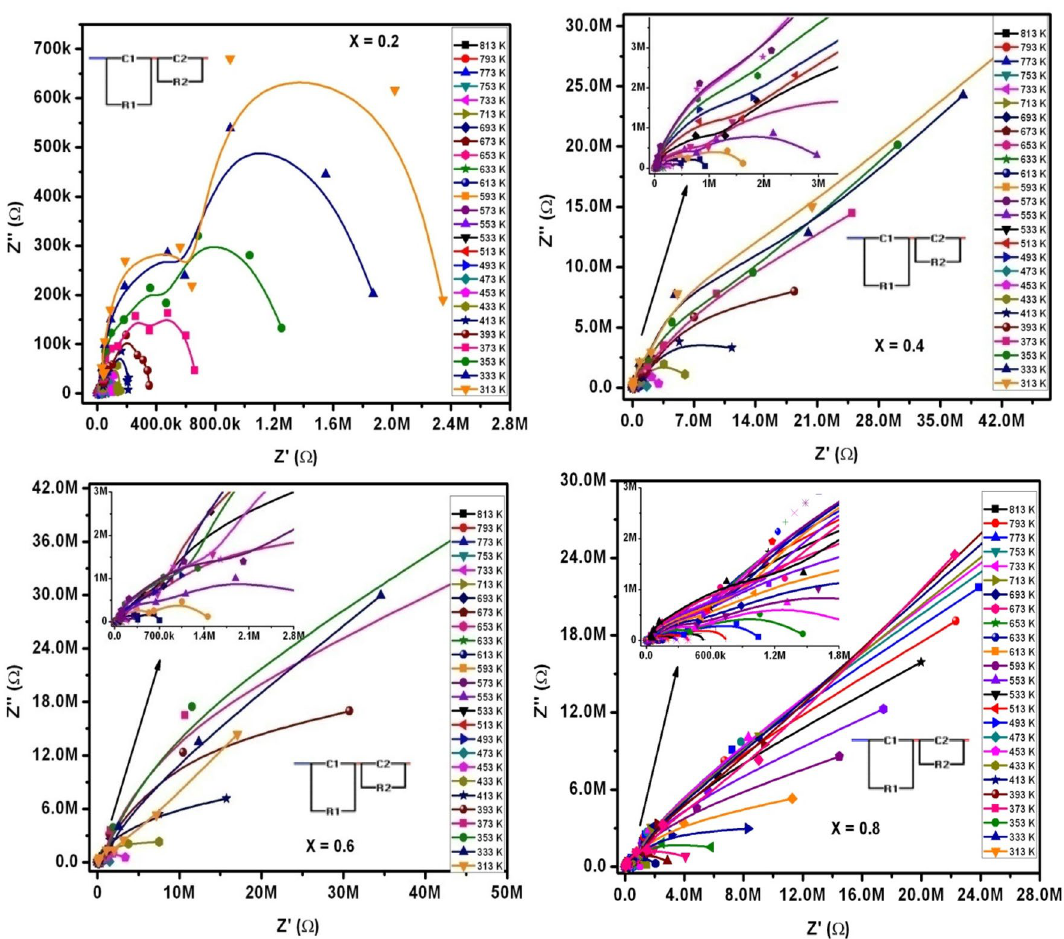
Figure 19. Z ′ versus Z ″ versus log f plots of SLFO